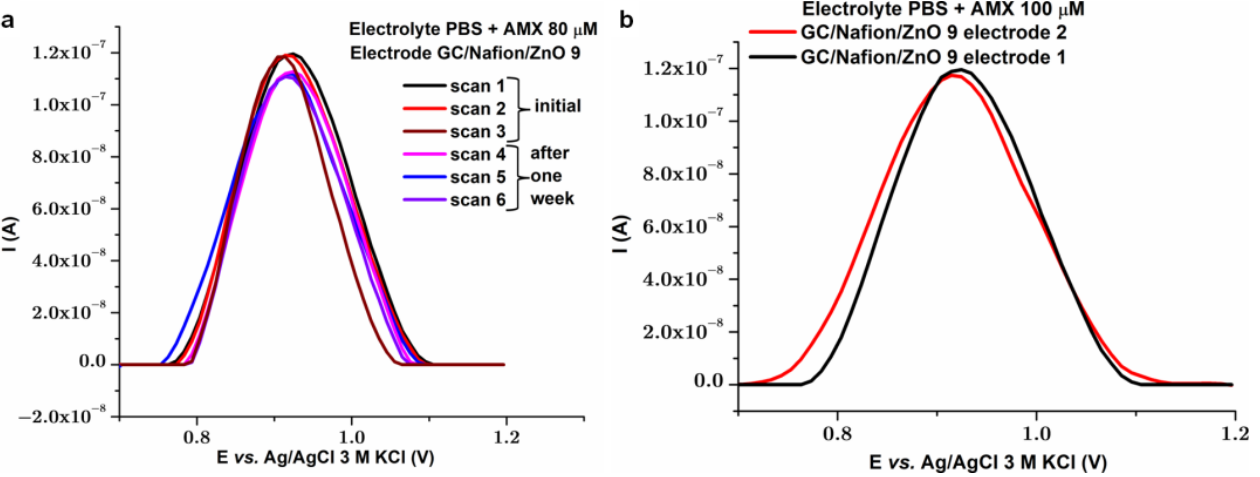
Figure 8. DPV curves in PBS + AMX 80 μM recorded with GC/Nafion/ZnO 9: ( a ) consecutive scans with the same electrode, ( b ) scans recorded with two freshly prepared electrodes.